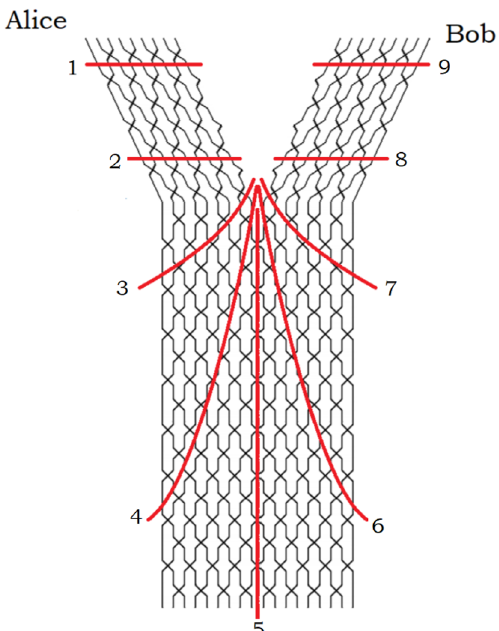
JHEP08(2020)121 Figure 10 . A foliation of the tensor network of (cid:12)gure 9 which interpolates between Alice’s side and Bob’s side. It is clear from the (cid:12)gure that the number of qubits cut by the slices increases and then decreases as the foliation sweeps round. Figure 11 . Successive spatial slices through a one-sided non-evaporating black hole that formed from collapse. The \whiskers" on the left side depict the infalling matter. The ‘bridge to nowhere’ grows and becomes elongated as the complexity increases. { 16